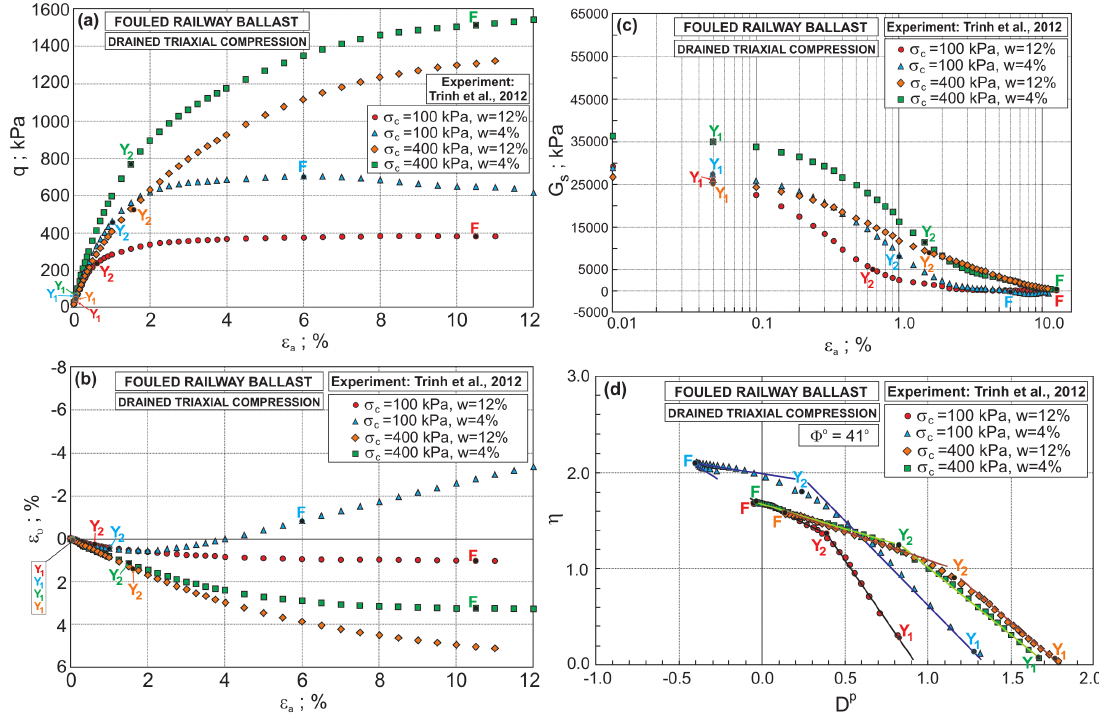
; (b) e – e ; (c) G – e ; and (d) h – D p . u a a s a